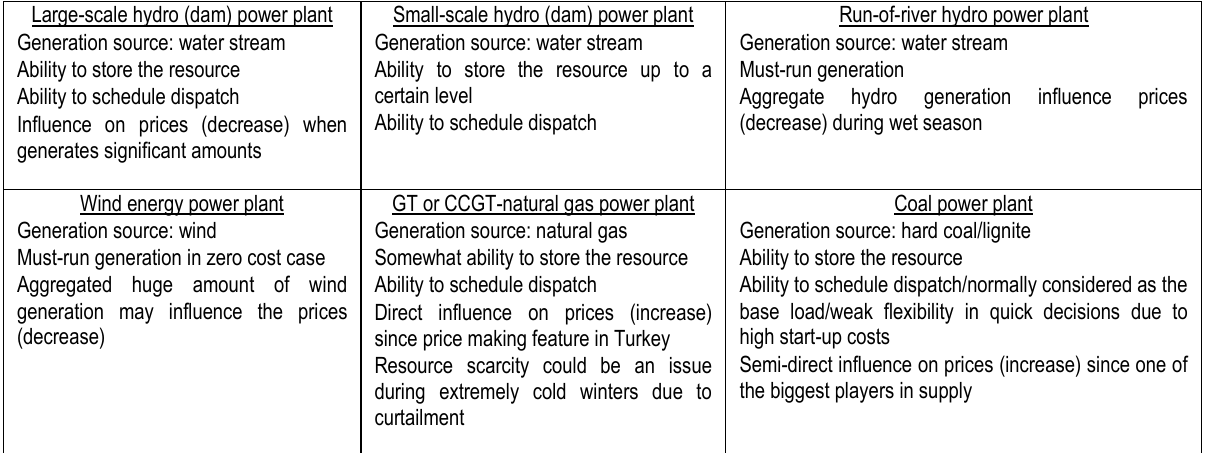
Table 1. Features of most prominent power plant types in